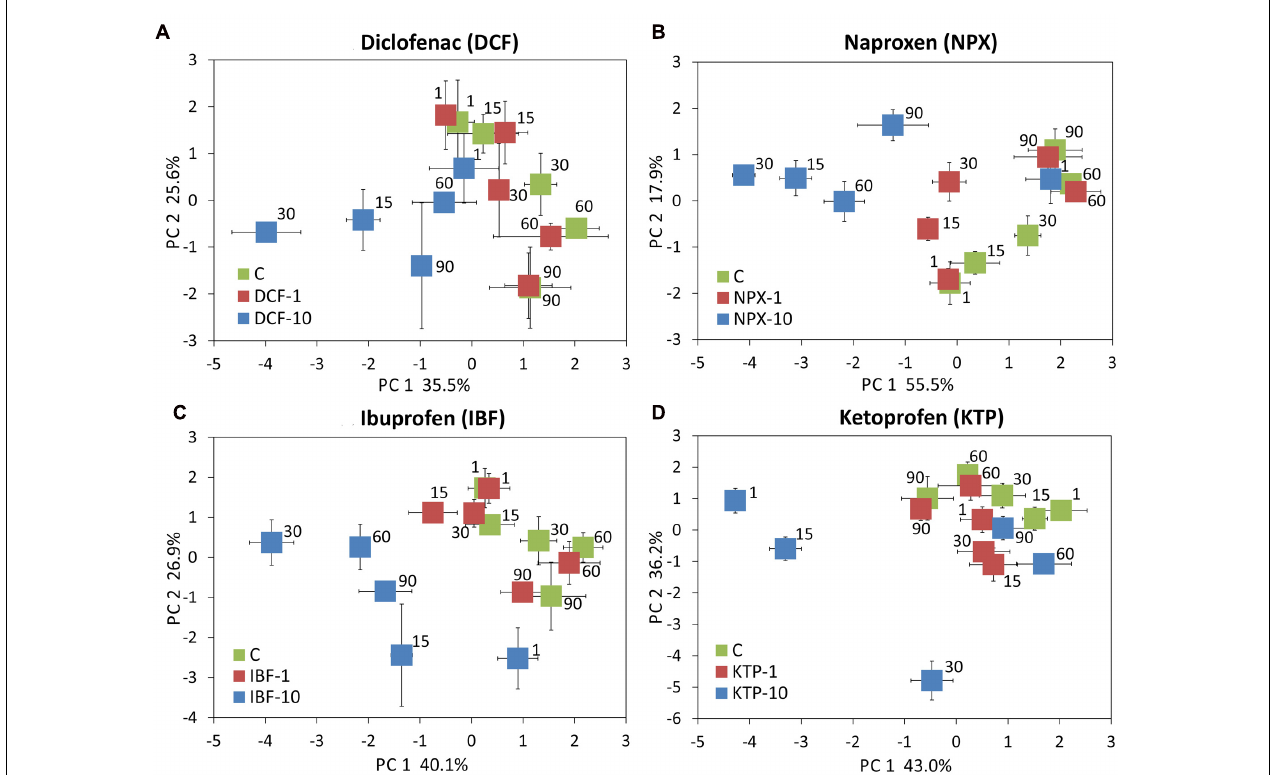
FIGURE 12 | Principal component plots generated from the measured parameters for diclofenac (A) , naproxen (B) , ibuprofen (C) , and ketoprofen (D) on days 1, 15, 30, 60, and 90. C, control soil; DCF-1, soil treated with diclofenac – 1 mg/kg soil; DCF-10, soil treated with diclofenac – 10 mg/kg soil; NPX-1, soil treated with naproxen – 1 mg/kg soil; NPX-10, soil treated with naproxen – 10 mg/kg soil; IBF-1, soil treated with ibuprofen – 1 mg/kg soil; IBF-10, soil treated with ibuprofen – 10 mg/kg soil; KTP-1, soil treated with ketoprofen – 1 mg/kg soil and KTP-10, soil treated with ketoprofen – 10 mg/kg